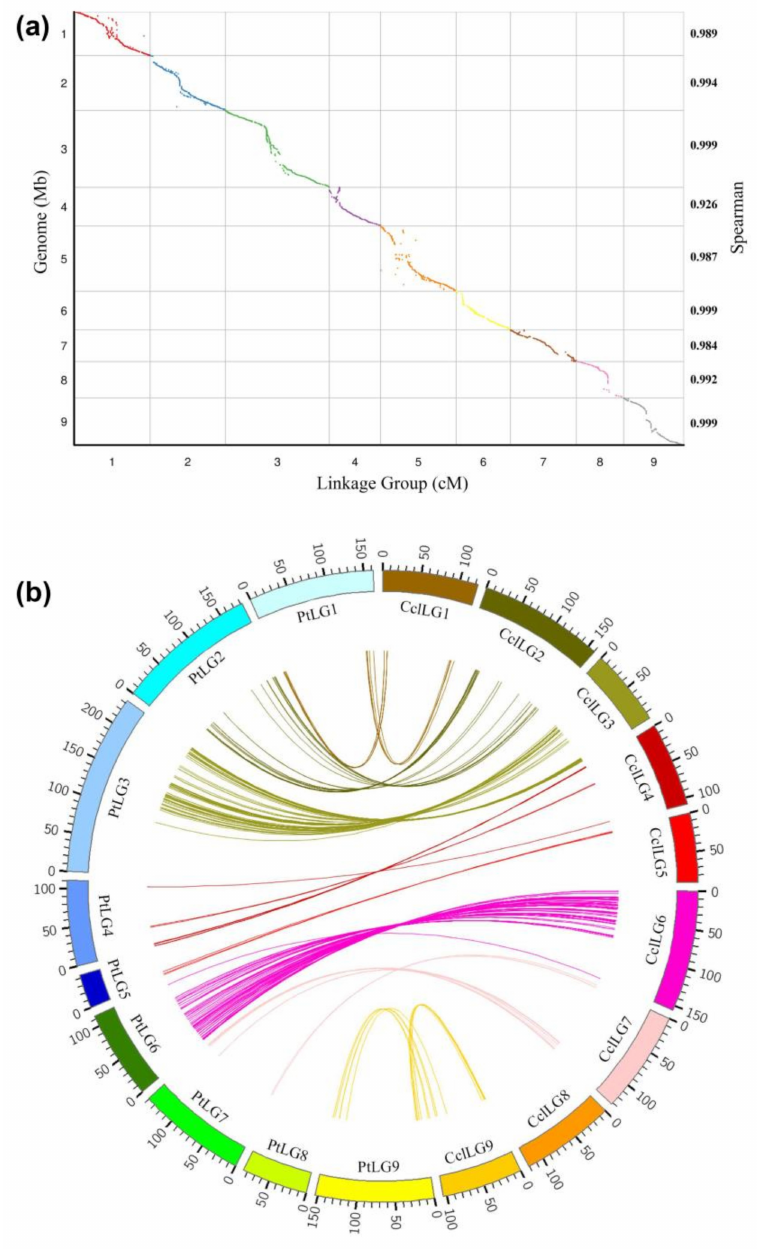
Figure 6. High-density genetic linkage map construction of citrus. ( a ) Collinearity analysis of all citrus linkage groups with its genome sequence. The x-axis scales the genetic distance of citrus LGs accordingly: the left y-axis represents the position of citrus pseudo-chromosomes and the right y-axis represents the Spearman correlation coefficient. SLAF markers in these LGs are plotted as dots. ( b ) Conservation of the synteny and linear order of markers between the female and male parent. Each colored arc represents an orthologous match between two species. Ccl: Clementine mandarin, Pt: Poncirus trifoliata